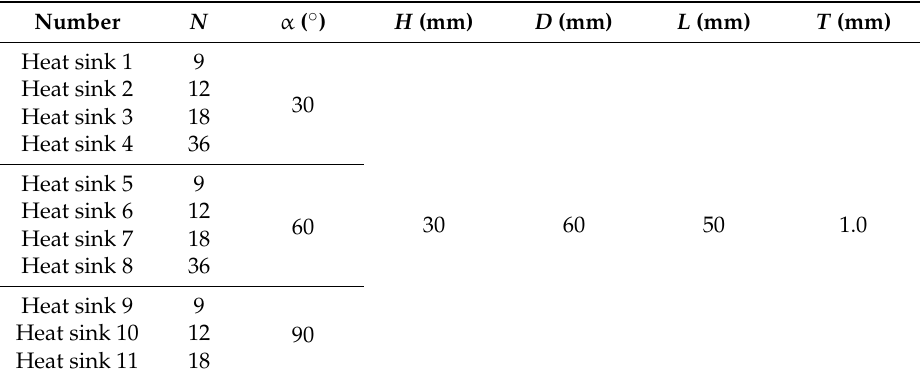
Table 1. Geometric configuration of tested heat